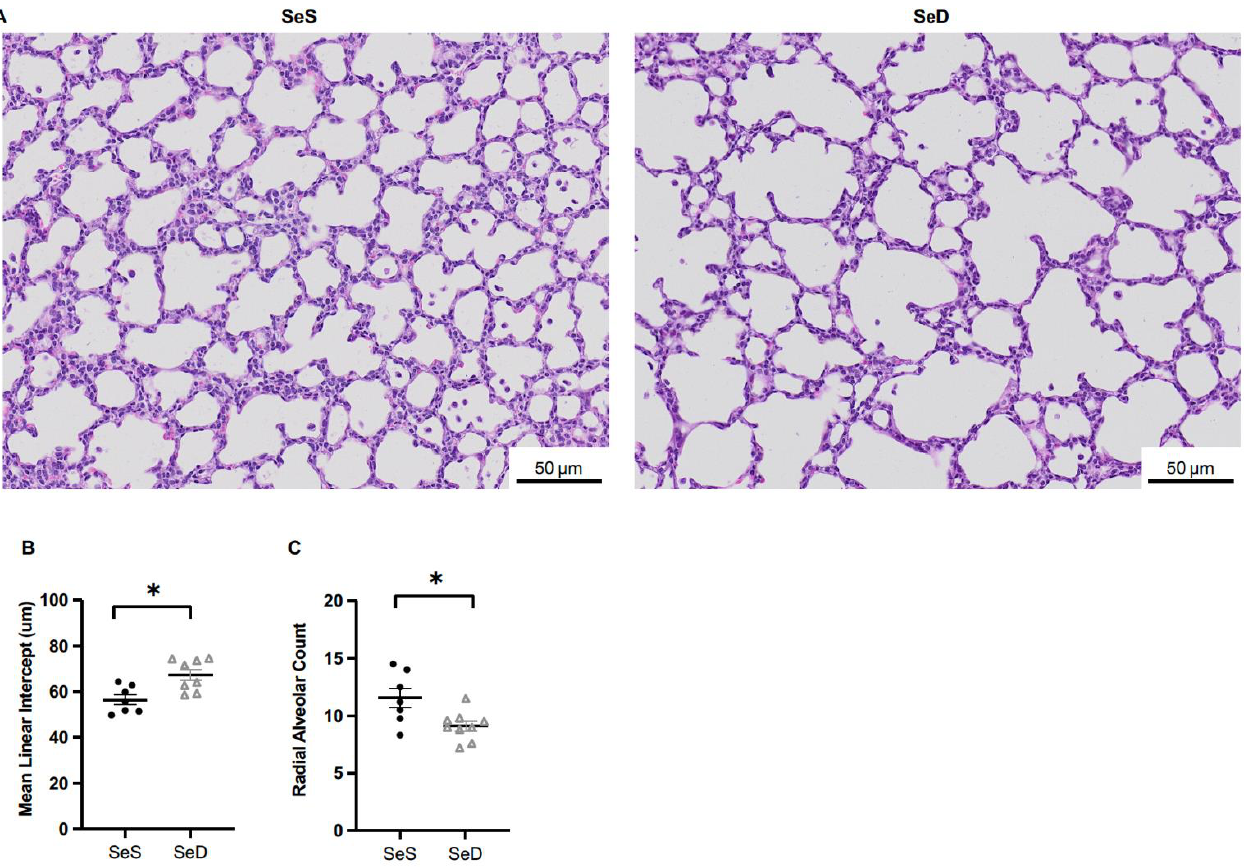
Figure 2. Neonatal Se deficient mice demonstrate impaired alveolar development at postnatal day 7. C57Bl/6 mice were placed on diets that differed only in Se content, either 0.4 ppm or <0.01 ppm of sodium selenite, through pregnancy and lactation. Alveolar development was assessed at postnatal day 7. ( A ) Representative images of lungs, ( B ) Mean linear intercept, ( C ) Radial alveolar counts. N = 7–9 for all groups. Data are presented as mean ( ± SEM), * p < 0.05 vs. SeS control by Students two-sided t -test.